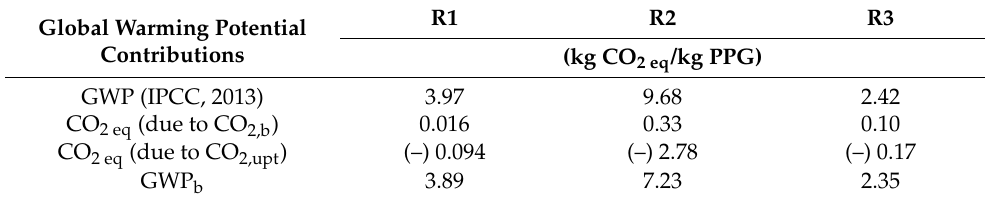
Table 3. Global warming potential considering biogenic carbon (GWP b ) for routes R1–R3. Global Warming